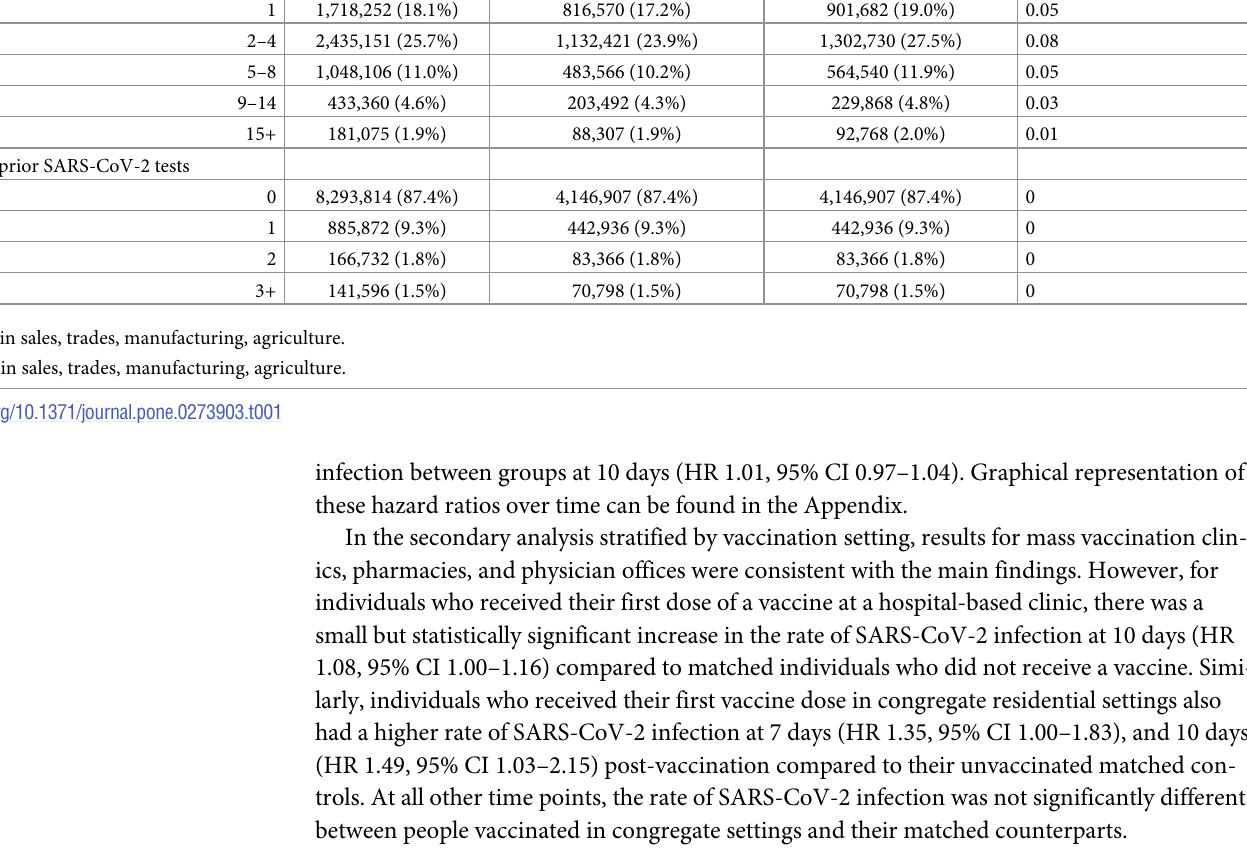
Table 2. Hazard ratios for the association between receipt of first dose of a COVID-19 vaccine and SARS-COV-2 infection according to time since vaccination and vaccination setting.